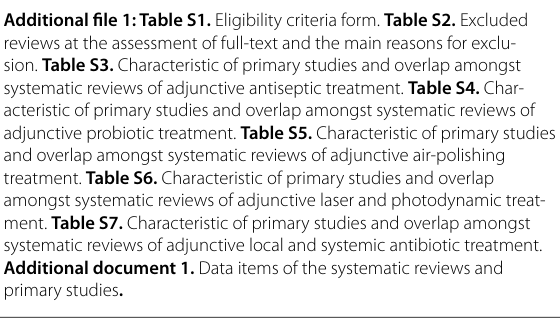
Additional file 1: Table S1. Eligibility criteria form. Table S2. Excluded reviews at the assessment of full-text and the main reasons for exclu- sion. Table S3. Characteristic of primary studies and overlap amongst systematic reviews of adjunctive antiseptic treatment. Table S4. Char- acteristic of primary studies and overlap amongst systematic reviews of adjunctive probiotic treatment. Table S5. Characteristic of primary studies and overlap amongst systematic reviews of adjunctive air-polishing treatment. Table S6. Characteristic of primary studies and overlap amongst systematic reviews of adjunctive laser and photodynamic treat- ment. Table S7. Characteristic of primary studies and overlap amongst systematic reviews of adjunctive local and systemic antibiotic treatment. Additional document 1. Data items of the systematic reviews and primary studies